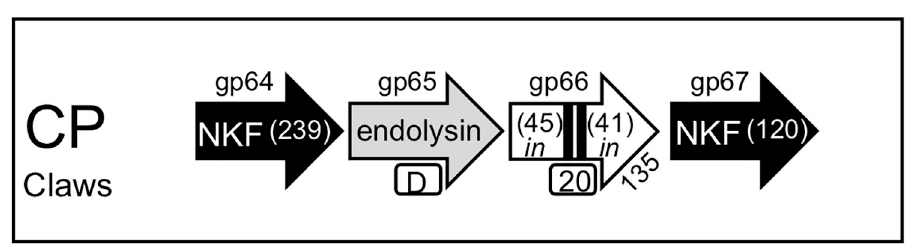
Fig 5. Genomic organization of a lysis cassette with a single transmembrane gene and no lysB . The genomic structure is show and the key to the schematic is presented in Fig 1. The direction of transcription of each gene is represented by the